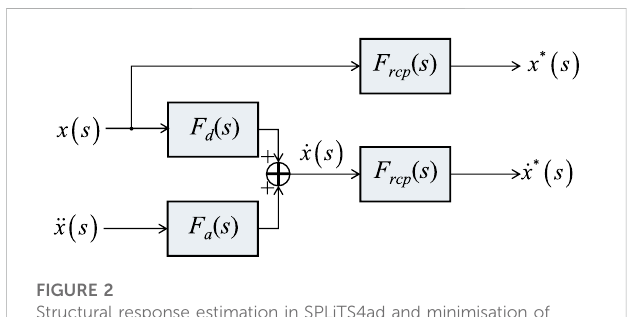
FIGURE 2 Structural response estimation in SPLiTS4ad and minimisation of the central-point shift components.